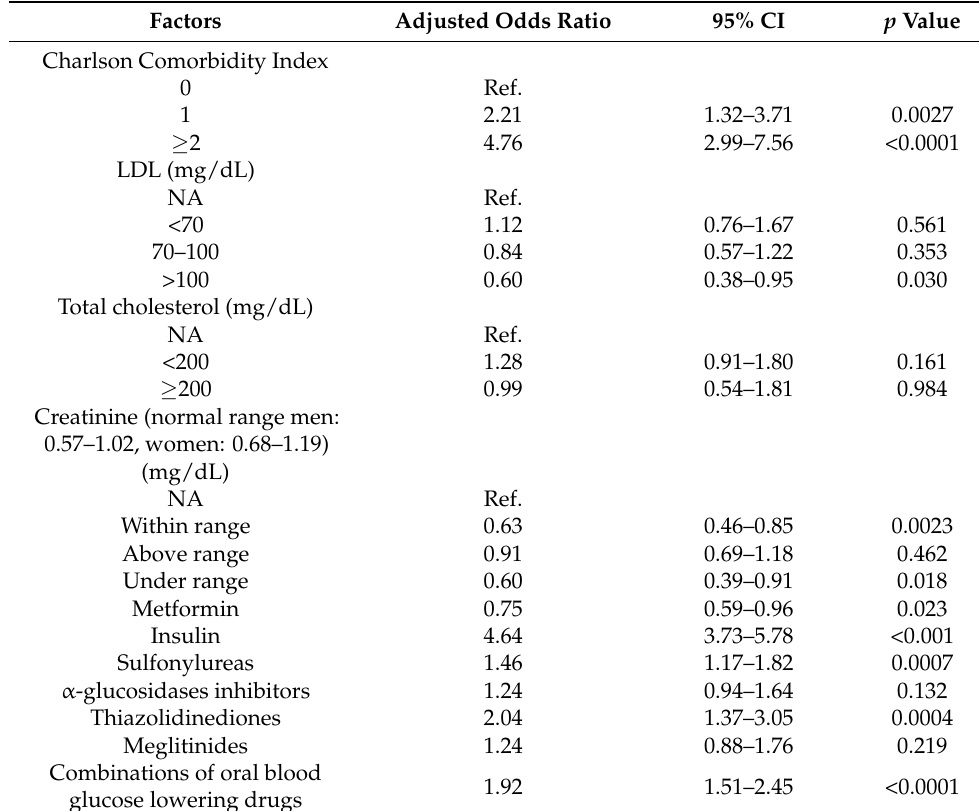
Table 4. Multivariable logistic regression model for risk of hypoglycemia in older patients with dementia and type 2